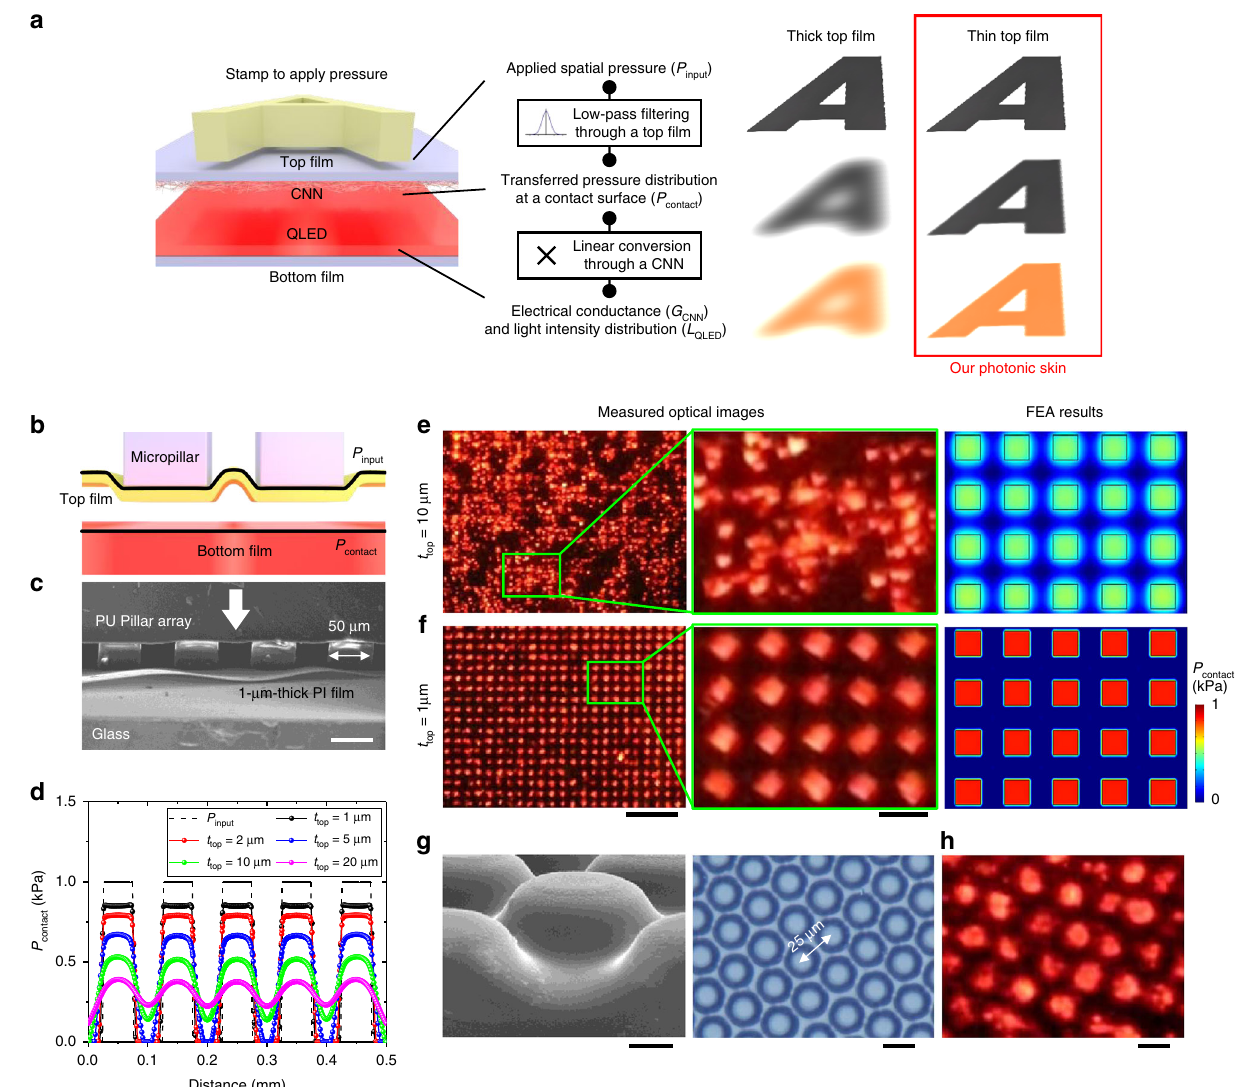
Fig. 4 Effect of the top fi lm thickness on the spatial resolution of the photonic skin. a Schematic illustration of the fl ow of the spatial signal when the pressure distribution ( P input ) is applied to the top fi lm of the photonic skin. The P input is low-pass fi ltered by the top fi lm, forming contact pressure distribution between the CNN and the ETL ( P contact ). The P contact is linearly converted into electrical conductance distribution between the CNN and the ETL ( G contact ) by the CNN. The light intensity distribution of the QLED ( L QLED ) is proportional to the G contact . b Schematic illustration of the situation where a micropillar array presses the top thin fi lm. In fi nite element analysis (FEA), we calculated the P contact between the top and bottom fi lms when P input was applied with the micropillar array. c SEM image where 50- μ m-wide PU pillars spaced by 50 μ m pressed a 1- μ m-thick polyimide (PI) fi lm on a glass substrate. Scale bar, 50 μ m. d FEA results showing a line pro fi le of P contact when a pillar array with a 50 µ m width and 50 µ m gap (254 dpi) pressed the top fi lm with different t top values. e , f Optical photographs where the 254 dpi PU pillar array pressed photonic skins with right images present FEA results showing P contact for the corresponding t top values. Scale bars, 500 and 100 μ m. g SEM and optical images of 1016 dpi PDMS hexagonal micro-bumps. Scale bars, 5 and 20 μ m. h Optical image of the device with t top ~ 1 µ m visualizing the pressure applied with the 1016 dpi hexagonal micro-bumps. Scale bar, 20 μ skin. ” The operation of the ultra fl exible devices laminated on human skin and a plastic fi bre is shown in Fig. 5f. When a fi nger and a glass rod touched the photonic skins attached onto the hand and the plastic fi bre, they showed touch information in real-time (Supplementary Movie 3). The device also visualized the pressure at valleys of wrinkles generated around the location of touch, which could be a good example of our device visualizing even unintended force, implying its high sensitivity and reliability.